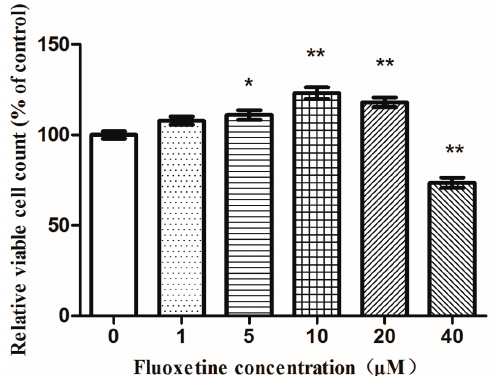
Figure 2. Effects of fluoxetine on astrocytes proliferation. A dose of 10 µM fluoxetine significantly increased astrocyte proliferation relative to untreated controls. Data reported as the means ± SEMs of five independent experiments ( n = 7). * p < 0.05; ** p < 0.01, compared with the drug-free controls.